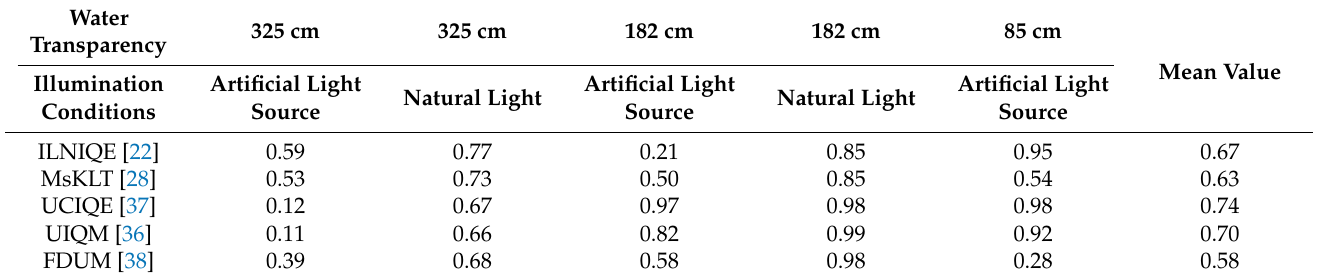
Table 6. PLCC between each method and ∆ E ∗ ab under different experimental